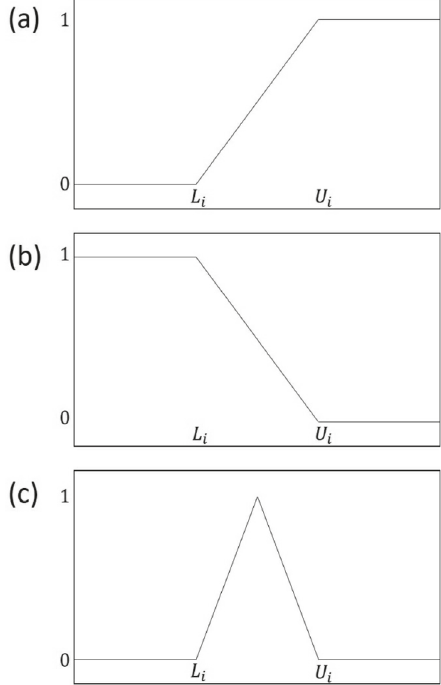
FIGURE 8 – Desirability functions to maximize (a), minimize (b), and target optimization, usually used in multiple response